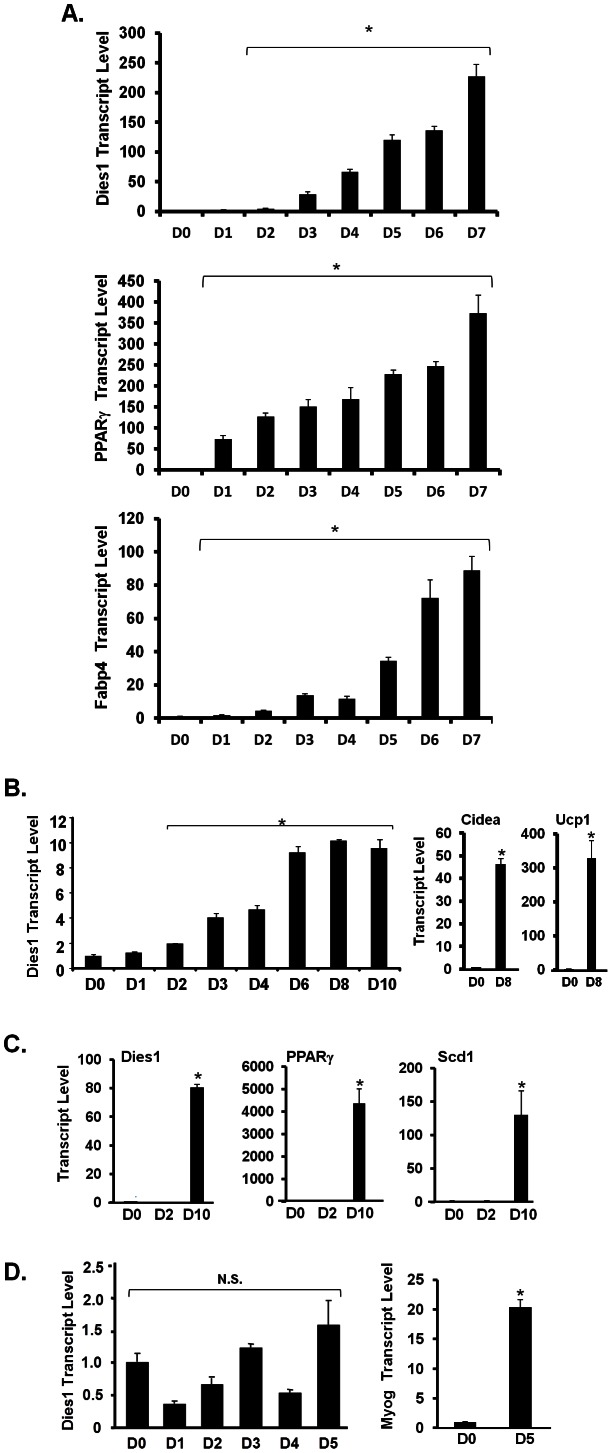
Dies1 Transcript Expression during in vitro Adipogenesis.RNA was purified at indicated time points (D, days) during a differentiation time course and levels of Dies1 or other indicated transcripts determined by qPCR for: A. 3T3-L1 adipogenesis;

B. WT-BAT brown adipogenesis; C. CH310T1/2 mesenchymal stem cell adipogenesis; D. C2C12 myogenesis. For D, left panel shows Dies1 transcript and the right panel transcript for the myogenesis marker myogenin (Myog). For A–D, the labeling of X-axis refers to days post induction of differentiation, with D0 indicating preadipocytes, except in the case of D, where D0 indicates C2C12 myoblasts. * indicates p<0.05, compared with the mean level at each of the D0 time points, which are set to a value of 1. The grouped data bars in A and B indicate statistical significance for each individual bar compared to the D0 value. For the left panel of D, N.S. indicates not-significant (p>0.05) for D5 vs. D0. Differentiation studies were conducted twice.